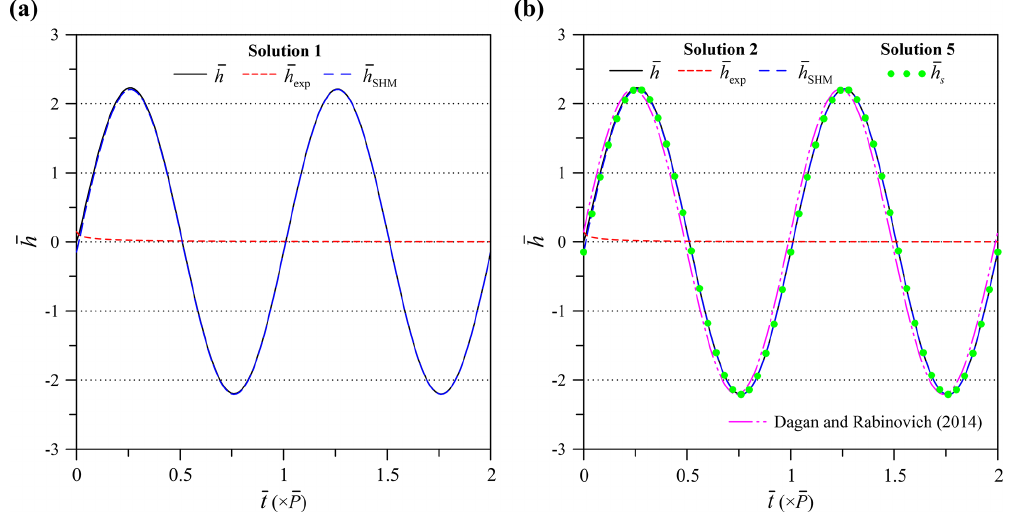
Figure 5. Head fluctuations at r = 6, predicted by (a) DGD Solution 1 and (b) IGD Solution 2. Solutions 1 and 2 are expressed as h = h exp + h SHM for transient flow. IGD Solution 5, expressed as h s = A s cos (γt − φ s ) , accounts for PSS